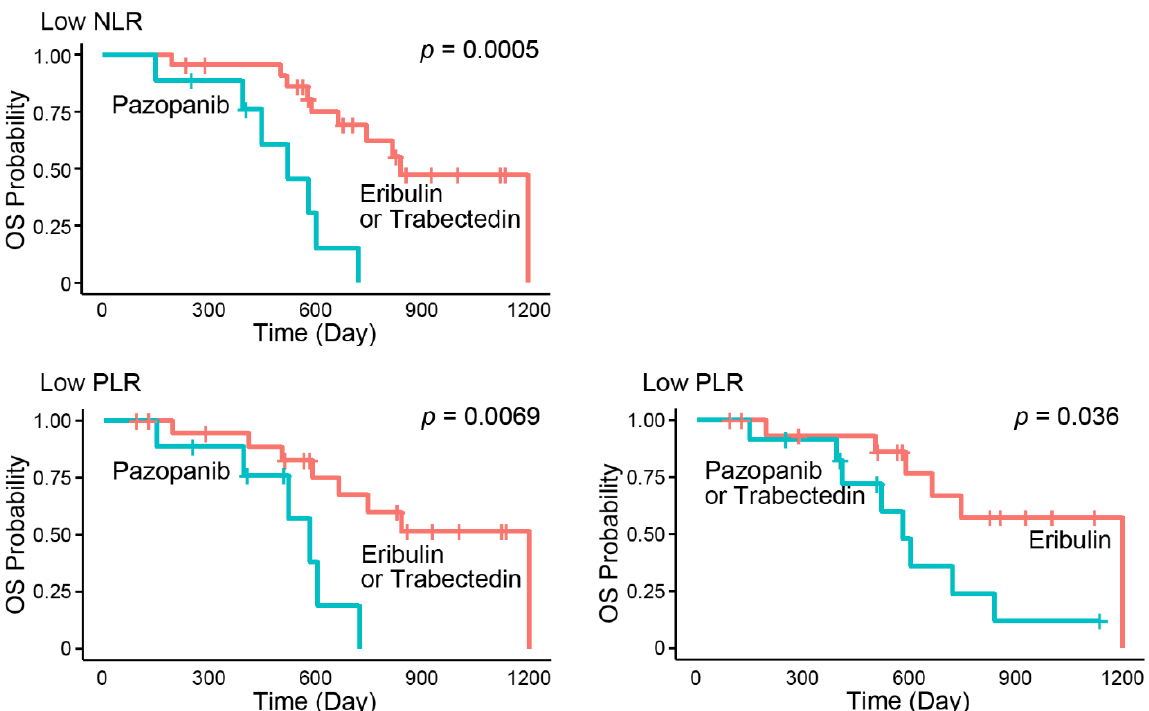
Figure 3. Subgroup analysis of OS among the first administered drugs. In the low NLR and the low PLR subgroup, pazopanib was associated with shorter OS than the others. In the low PLR subgroup, eribulin was associated with longer OS than the others. NLR, neutrophil–to–lymphocyte ratio. PLR, platelet–to–lymphocyte ratio.